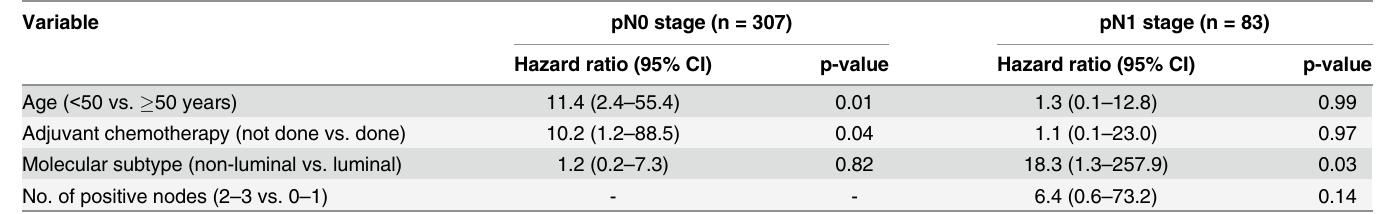
Table 3. Multivariate analysis for locoregional recurrence in stage N0, N1 patients.